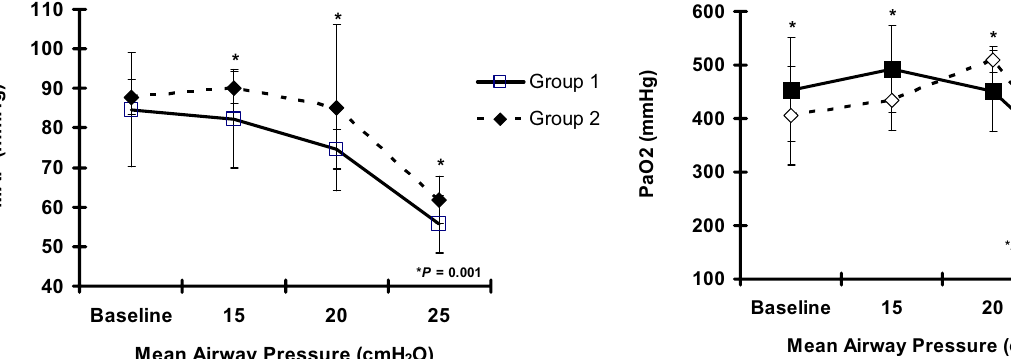
FIGURE 3 - Partial Oxygen Pressure: PaO significant lower when 2 MAP was adjusted at 25cmH O were when compared to all other MAP O and 20 2 2 ( P =0.001) There was a significant difference between the PaCO 2 values when the MAP was 15cmH O when compared to the 2 MAP at 25cmH O ( P =0.039), however there was no signifi- 2 cant difference between MAP 20cmH O and MAP 25cmH O 2 2 ( P =0.07). When comparing dynamic respiratory measurements, all values of PEEP until MAP 25cmH O did not increase pla- 2 teau pressure above 30cmH O. On the other hand, a MAP 2